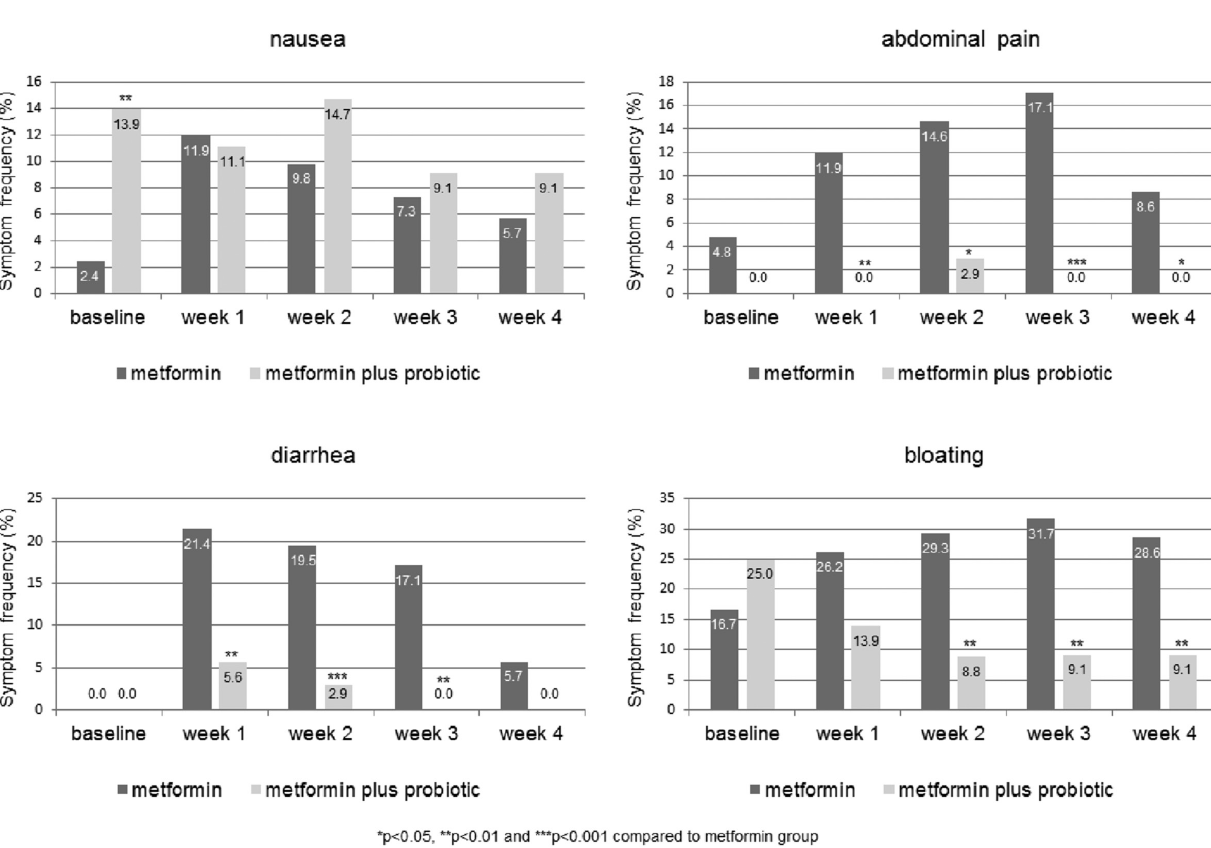
Figure 1. Weekly gastrointestinal symptom frequency in metformin alone and metformin plus probiotic (BB-12) groups of patients with treatment